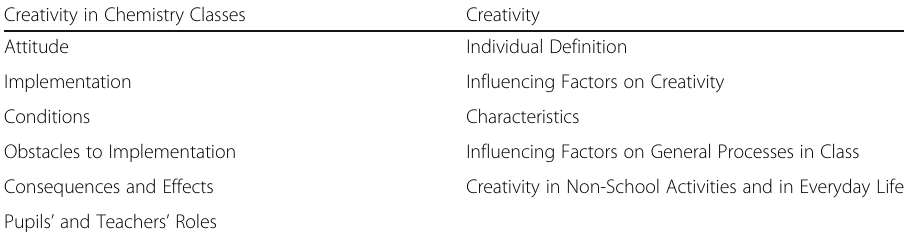
Table 4 Categories for evaluation of the concept